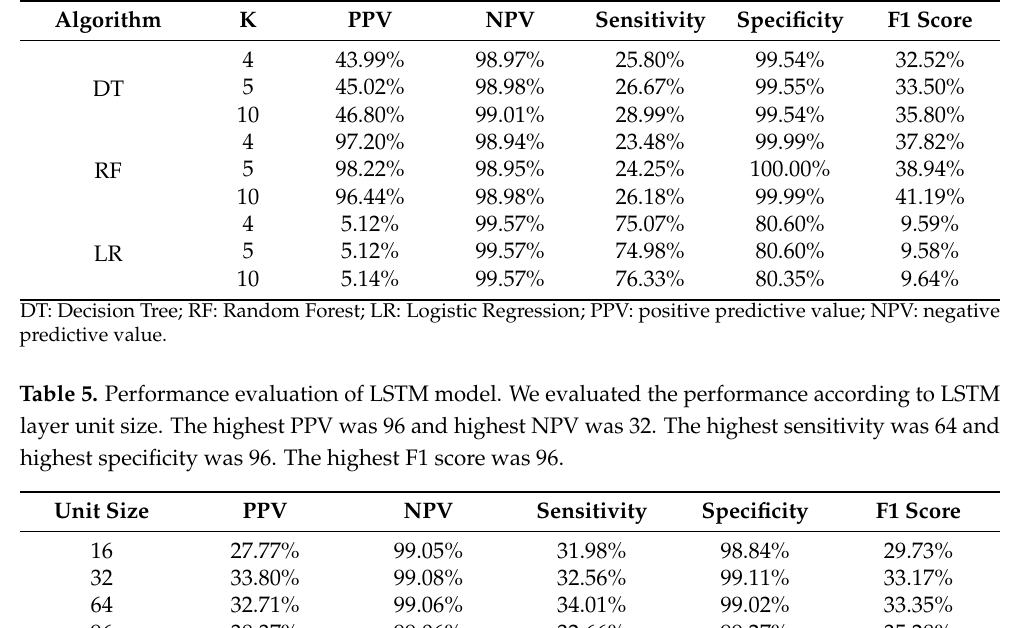
Table 4. Performance evaluation of shallow machine learning performed by changing the value of k in the stratified K-fold. The highest PPVs in DT, RF, and LR were 10, 5, and 10, respectively.